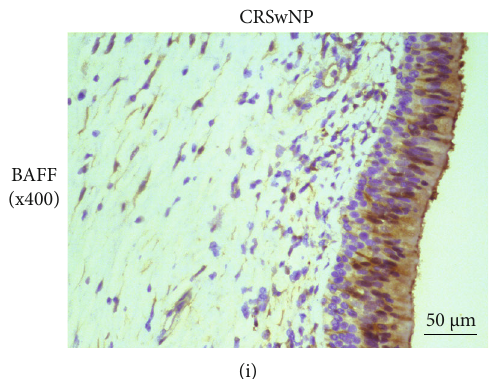
Figure 4: Histopathology and BAFF protein expression in the tissue among three groups. (a – c) Representative H&E images from HC, CRSsNP, and CRSwNP. (d – i) Representative IHC staining of BAFF in HC, CRSsNP, and CRSwNP (magni fi cation, 200x and 400x). BAFF: B cell-activating factor; H&E: hematoxylin and eosin; CRSwNP: chronic rhinosinusitis with nasal polyps; CRSsNP: chronic rhinosinusitis without nasal polyps; HC: healthy control; IHC: